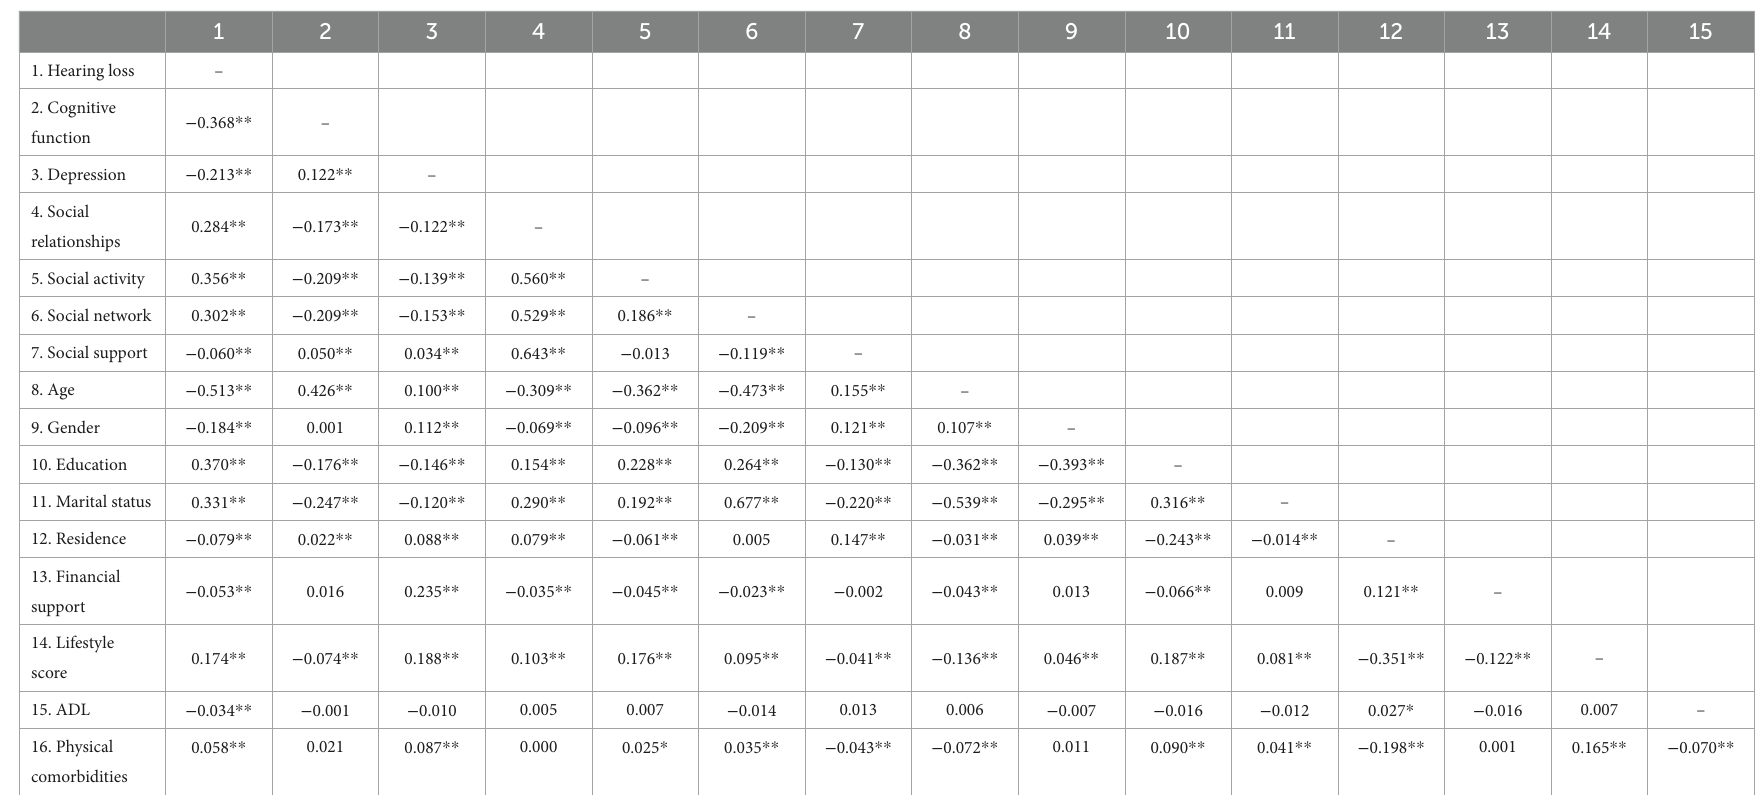
TABLE 2 Correlations for the study